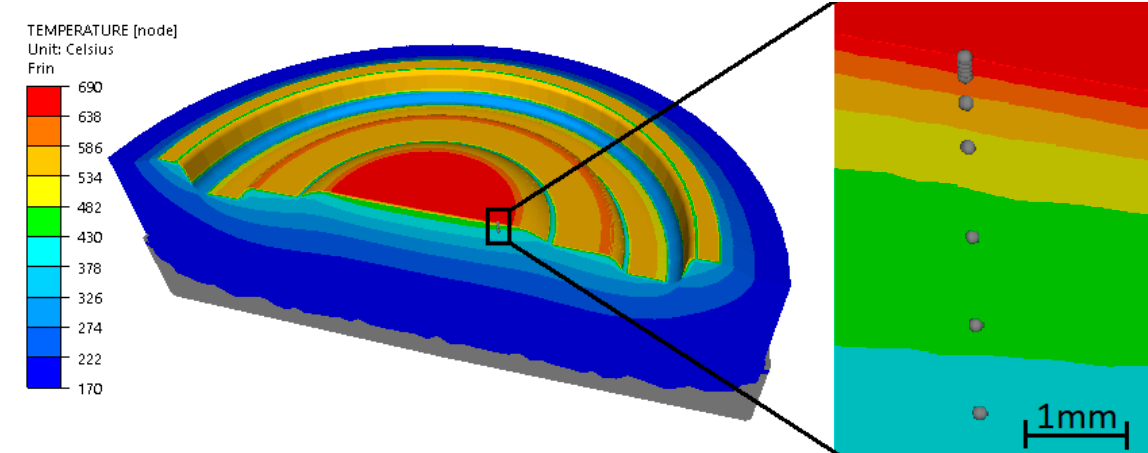
Figure 8. Temperature distribution in the last (41st) of two forging operations—the last forming step and the location of sensors in the numerical model.